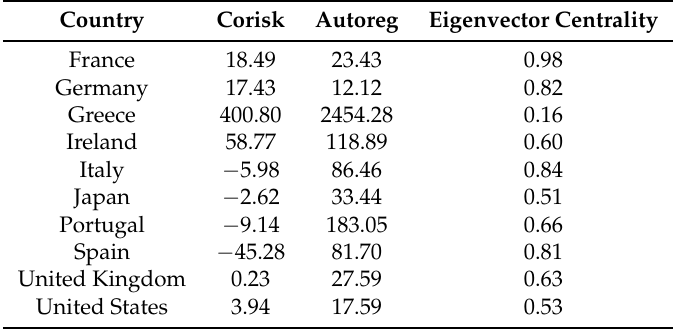
Table 3. Comparison between the two components of risk obtained with our proposed structural VAR model ( CoRisk and autoregressive parts) and the eigenvector centrality